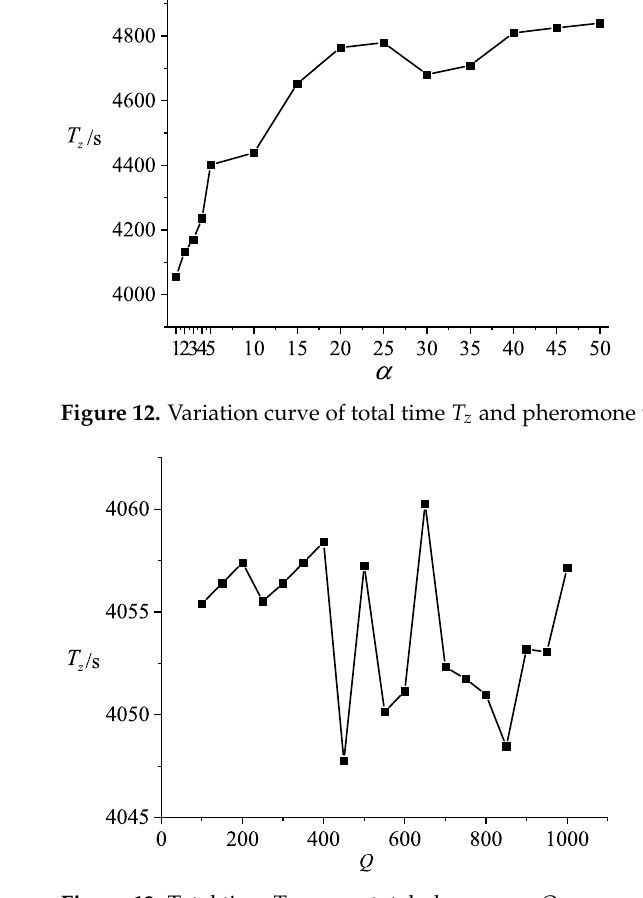
Figure 13. Total time T z versus total pheromone Q .